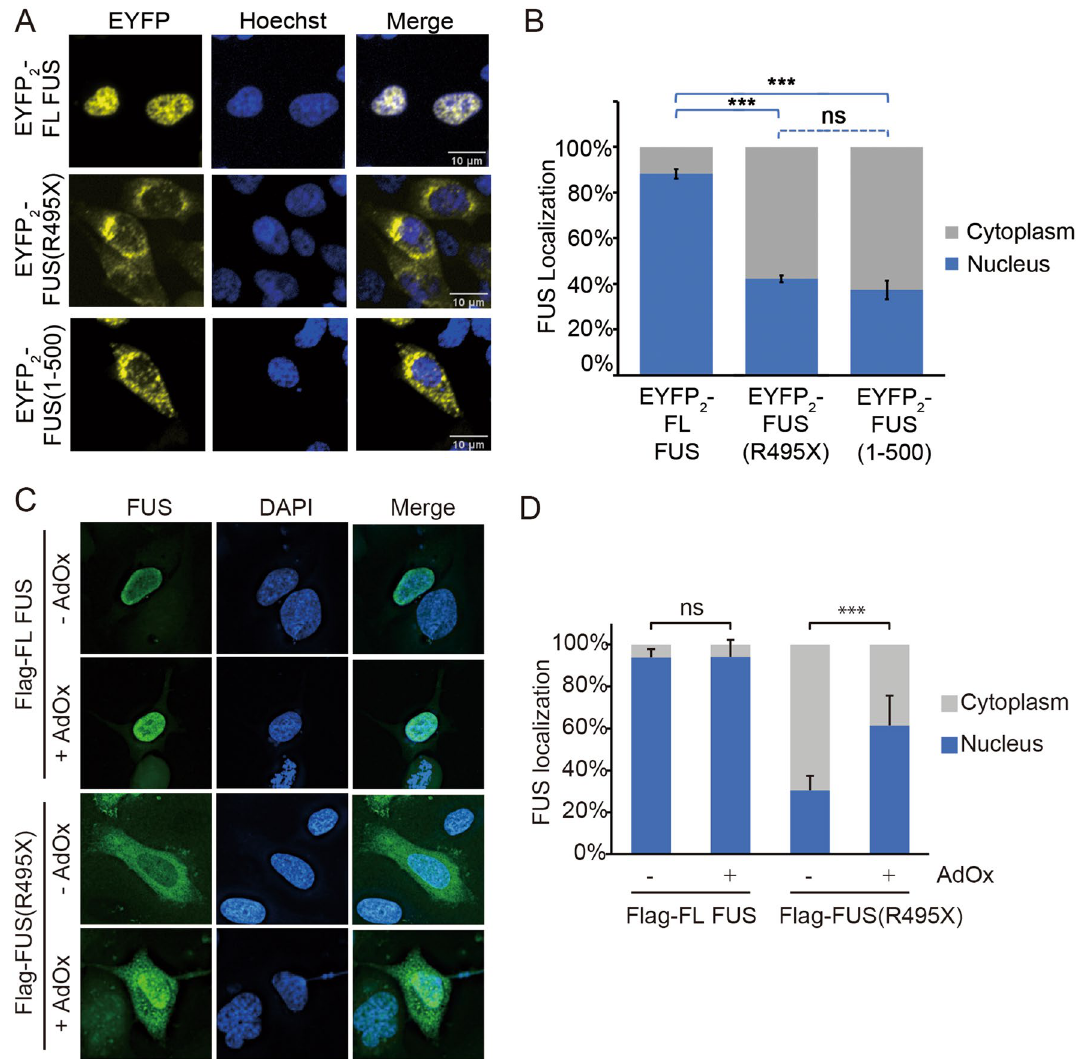
Figure 5. Localization of full-length FUS, FUS(R495X) and FUS(1–500) in HeLa cells. ( A ) Confocal microscopic images of live HeLa cells expressing EYFP 2 -FL FUS, EYFP 2 -FUS(R495X) or EYFP 2 -FUS(1–500). ( B ) Bar diagram of relative percentage of nuclear and cytoplasmic fluorescence intensity in cells, with the mean ± SEM, n = 10–14. Significant differences compared with the corresponding control samples are indicated ***p < 0.001. ns, not significant (Ordinary one-way ANOVA test). ( C ) Fluorescence microscopic images of fixed HeLa cells expressing Flag-FL FUS or -FUS(R495X), with or without methylation inhibitor AdOx (20 μM) treatment. FUS is visualized by immunofluorescence (Alexa 488 secondary antibody). ( D ) Bar diagram of relative percentage of nuclear and cytoplasmic fluorescence intensity of cells in ( C ). More than 30 cells were analyzed for each experiment. Error bars represent standard deviation. ***Indicates adjusted P values <